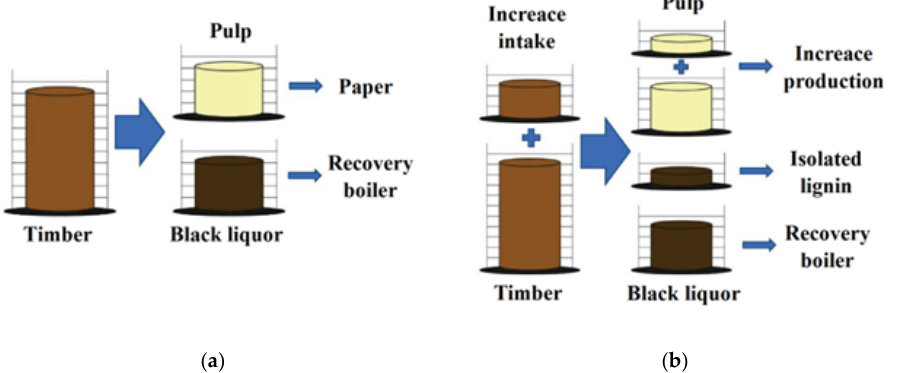
Figure 1. Diagram of the current state of paper industry production ( a ); and benefits of the isolation of lignin for other industrial uses ( b ).